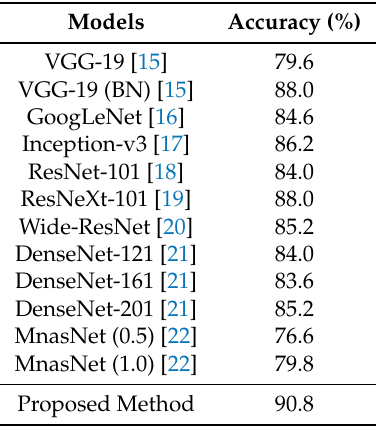
Table 2. Performance comparison with the existing CNNs on indoor/nature/city classes.